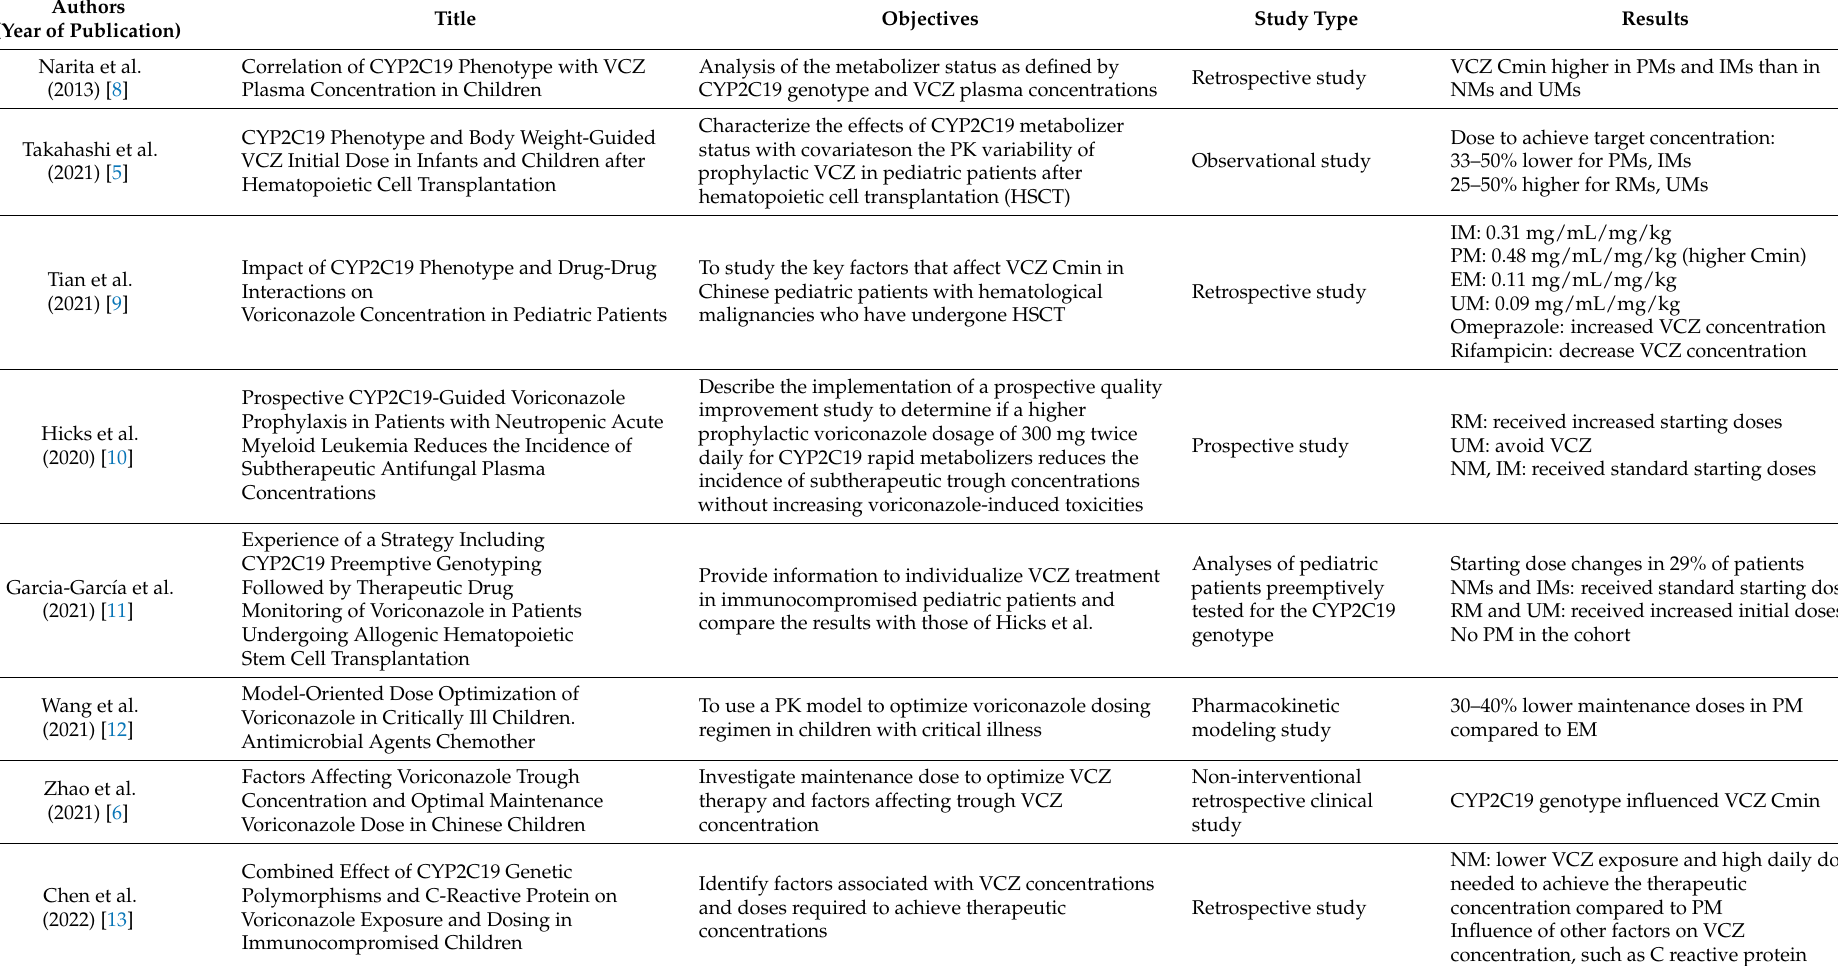
Table 2. Summary of studies on the influence of the CYP2C19 genotype on the concentration of VCZ in pediatric